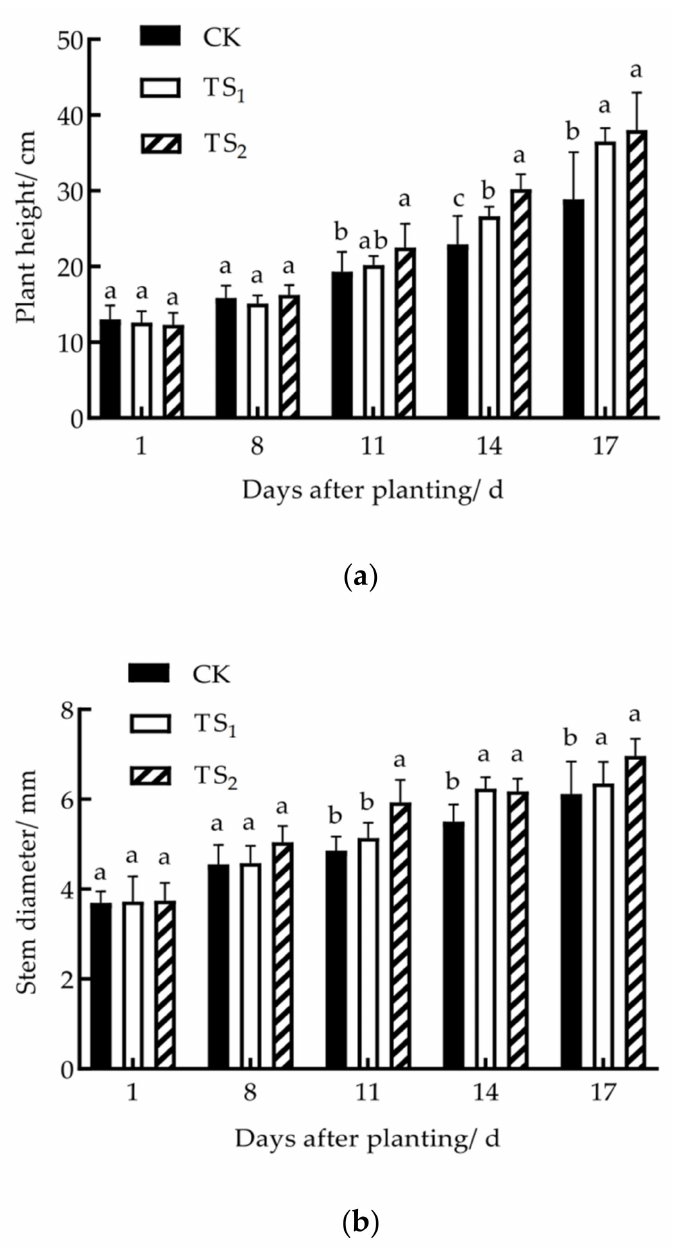
Figure 7. Effects of WCTRZSCS on tomato plant height and stem diameter. ( a ) Plant height; ( b ) stem diameter. Different lowercase letters on the same day indicate significant differences between different regions ( p <